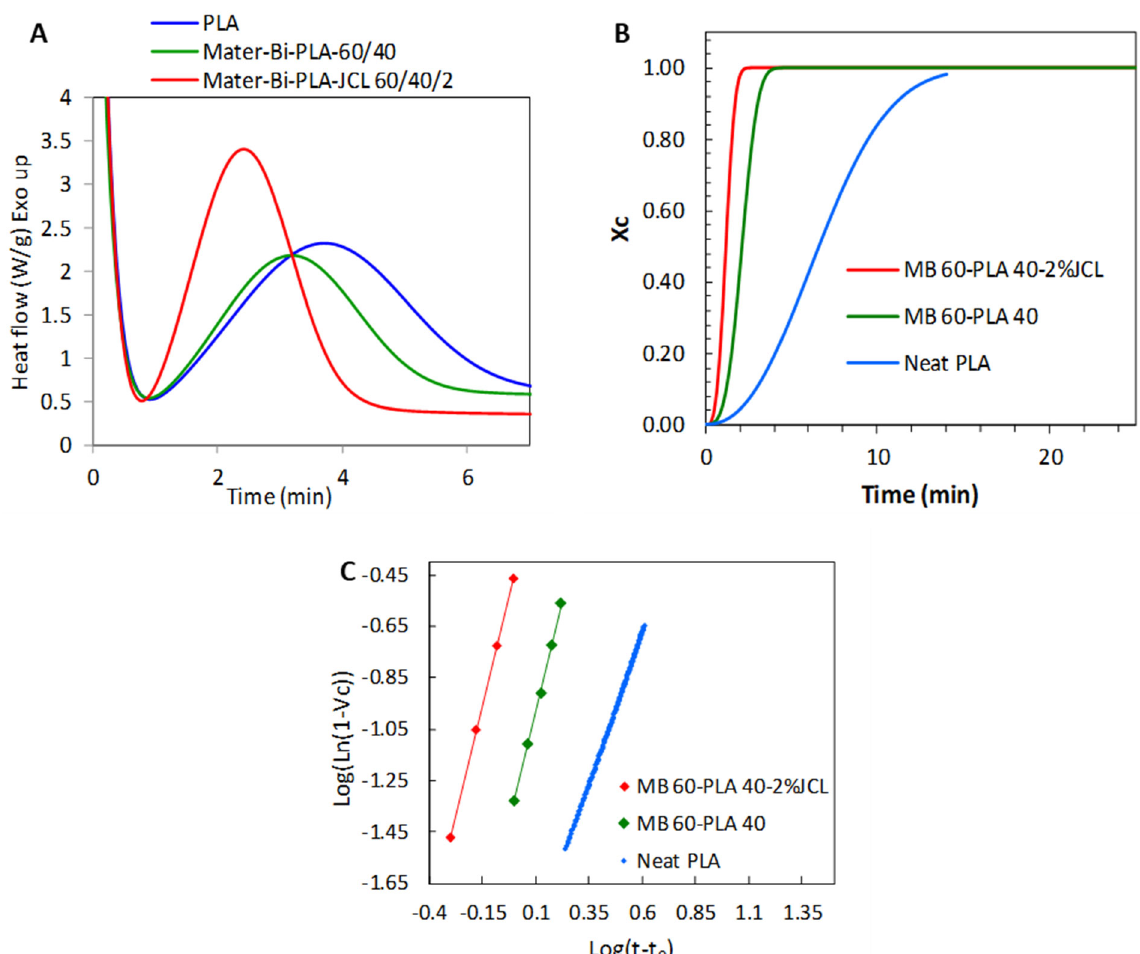
Figure 6. Avrami analysis isothermal data at 120 °C: ( A ) experimental isothermal data, ( B ) the relative crystallinity with time, and the ( C ) Avrami Log–Log plot. Table 5. Parameters of the Avrami fit obtained from isothermal analysis at 120 °C of 60/40 Mater ‐ Bi/PLLA blend: Avrami exponent (n), predicated half ‐ time crystallization ( t 1/2 Theo), experimental half ‐ time ( t 1/2 exp), overall transformation constant (k), and correlation coefficient (R 2 ).